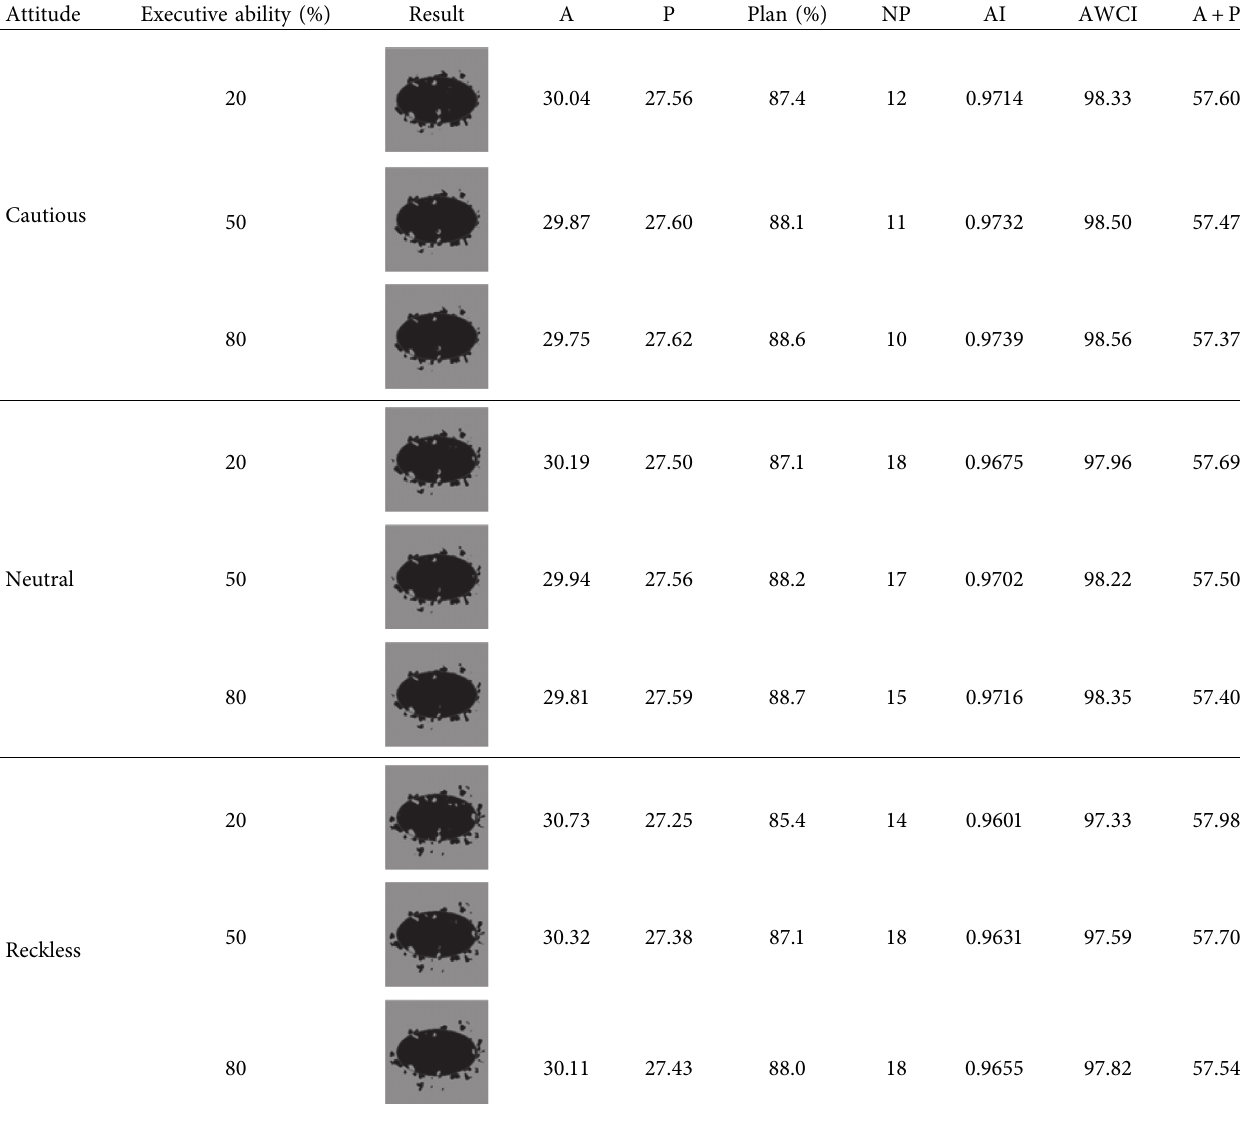
Table 3: Results of land development in the situation of planning coordinating with the city’s self-organizing laws.